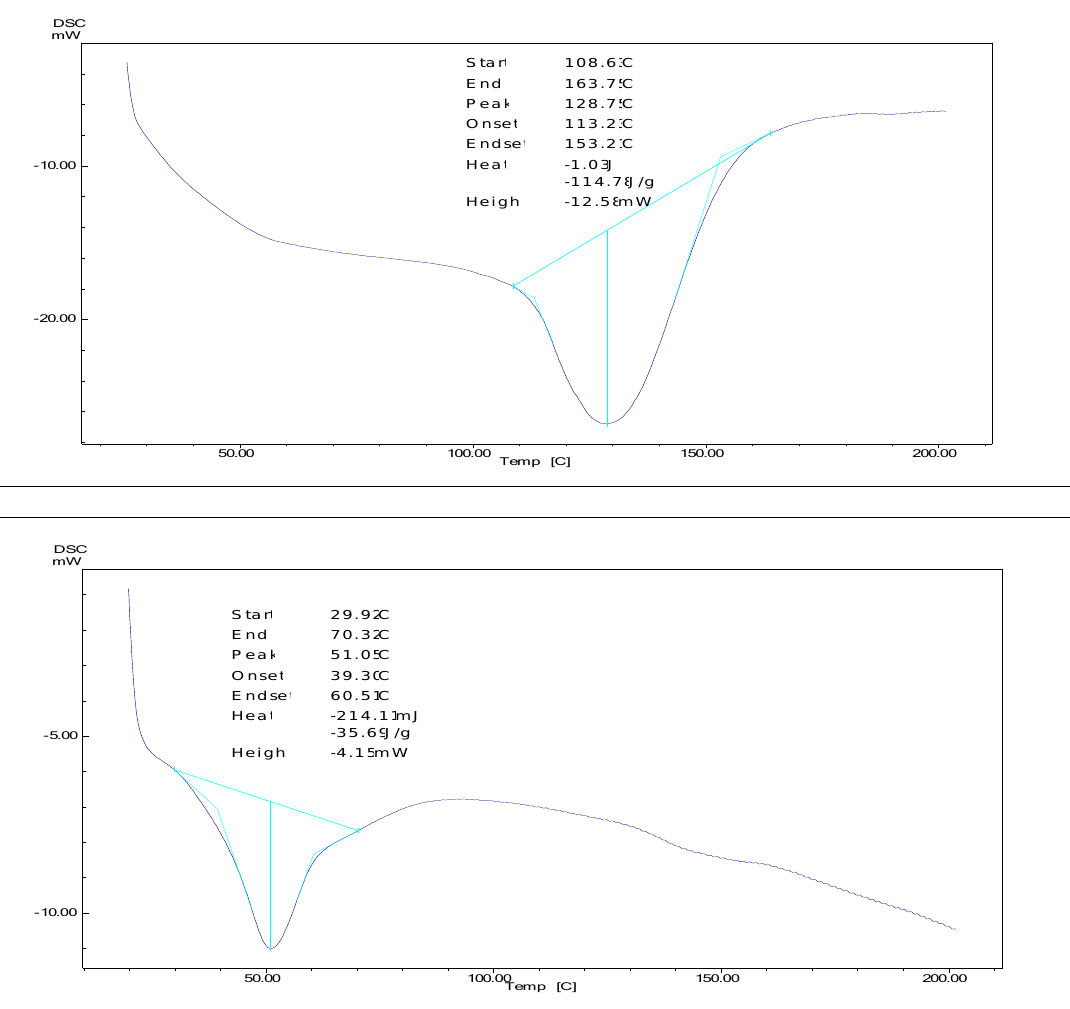
Figure 6. DSC thermograms of pure AC powder, F11 and